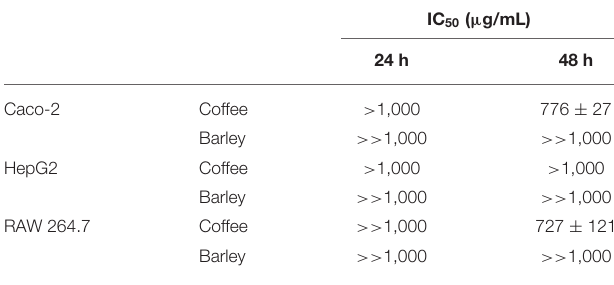
TABLE 4 | In vitro assessment of ISC and ISB EtSn melanoidin population inhibitory activity (%) against acetylcholine esterase (AChE), tyrosinase, elastase, α -glucosidase, and α